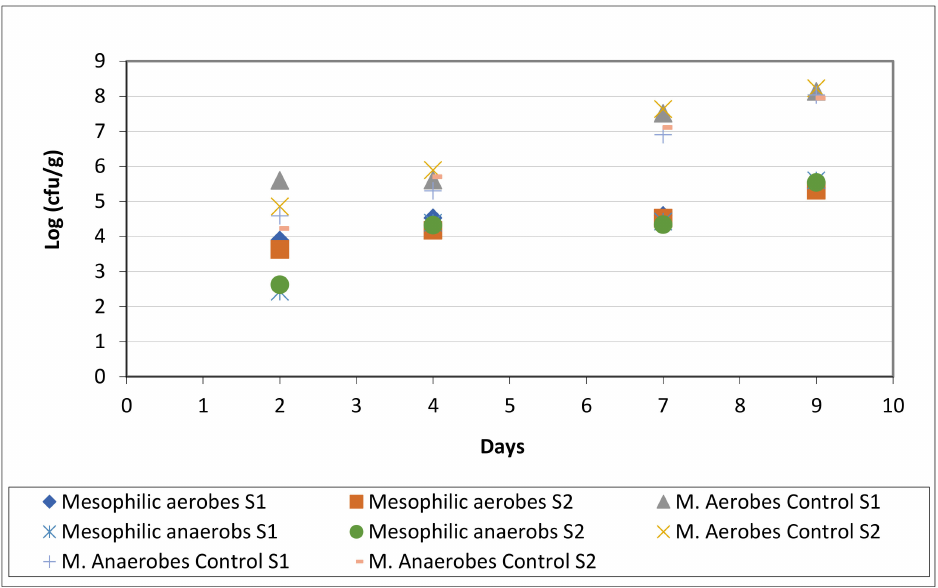
Figure 12. Microbiological count of sea bam packed in nanocomposite material and in